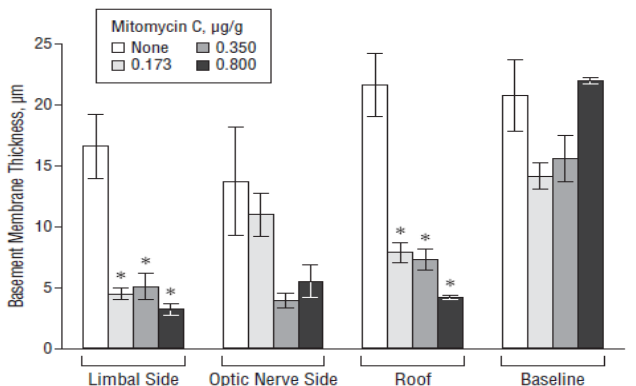
Figure 5. Effect of the poly(2-hydroxyethylmethacrylate) (pHEMA)/mitomycin C-modified Ahmed valve on the fibrous capsule thickness in various regions of the bleb wall. The bar designated as “none” represents the control rabbits implanted with an unmodified Ahmed valve. * p < 0.05. Reproduced from Reference [183] .